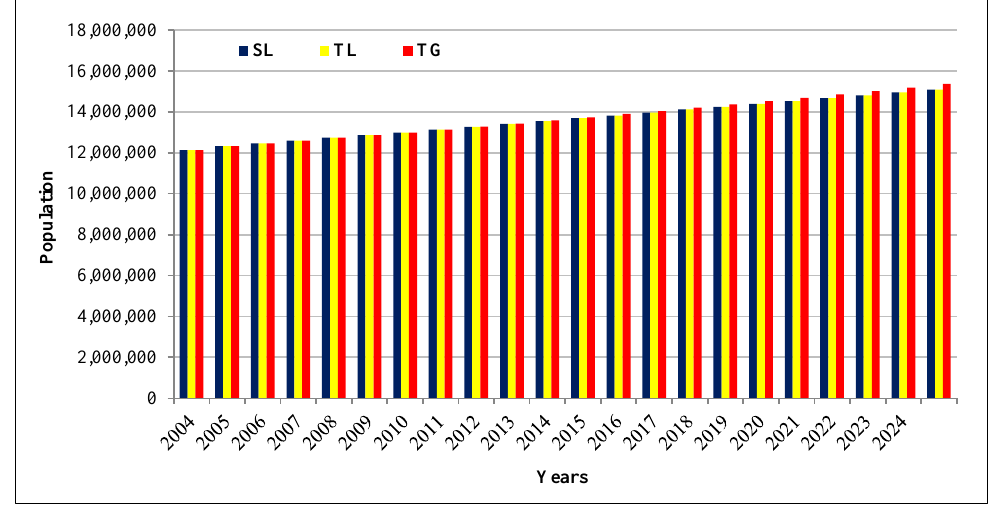
Figure 3. Graph of population test results